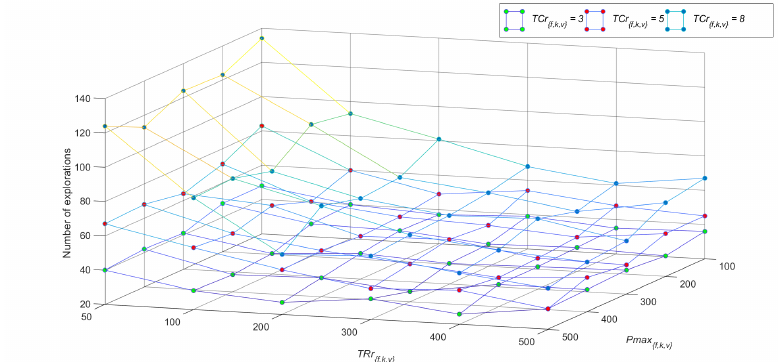
Figure 8. The number of space explorations after 30,000 iterations; we added 50 agents to the group in the 1000th iteration and removing agents was then turned off.